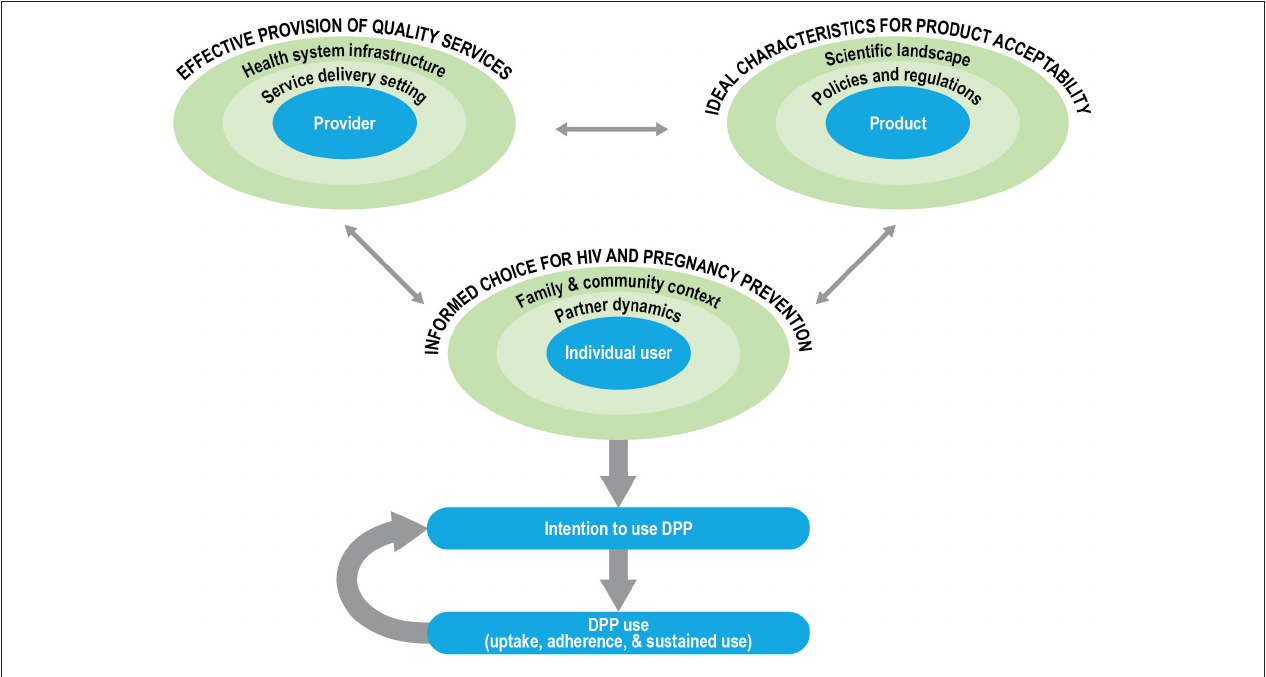
FIGURE 2 | Framework for DPP development and